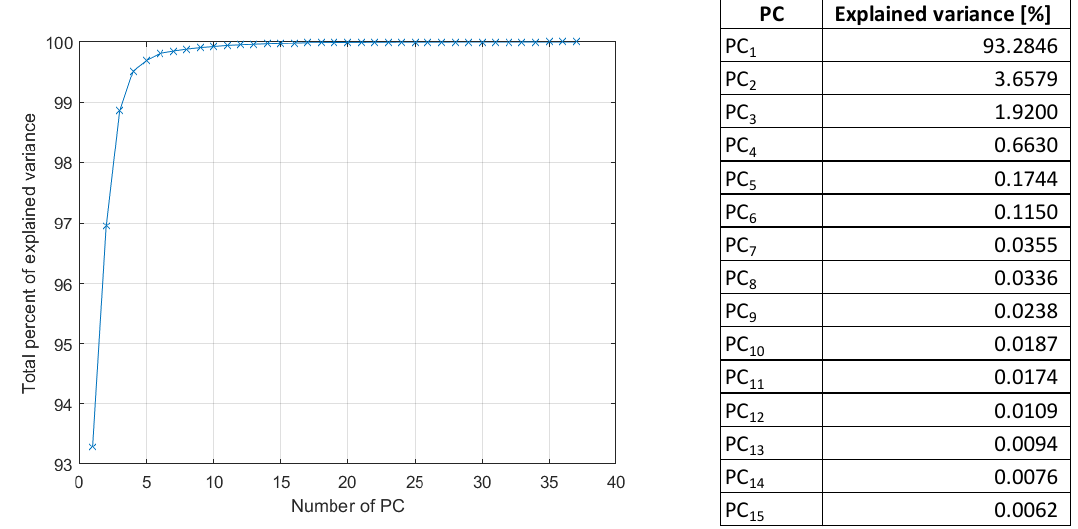
Figure 7. The coefficients for first four principal components.